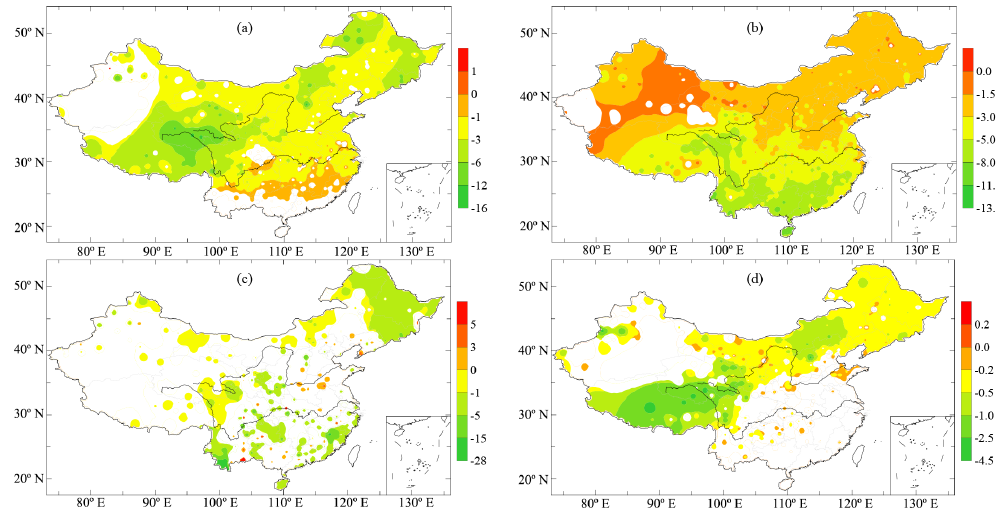
Figure 7. Spatial trend of annual days of high-impact weather in China during 1959–2014 (unit: days decade − 1 ; (a) snowfall days, (b) thun- derstorm days, (c) foggy days, (d) hailstorm